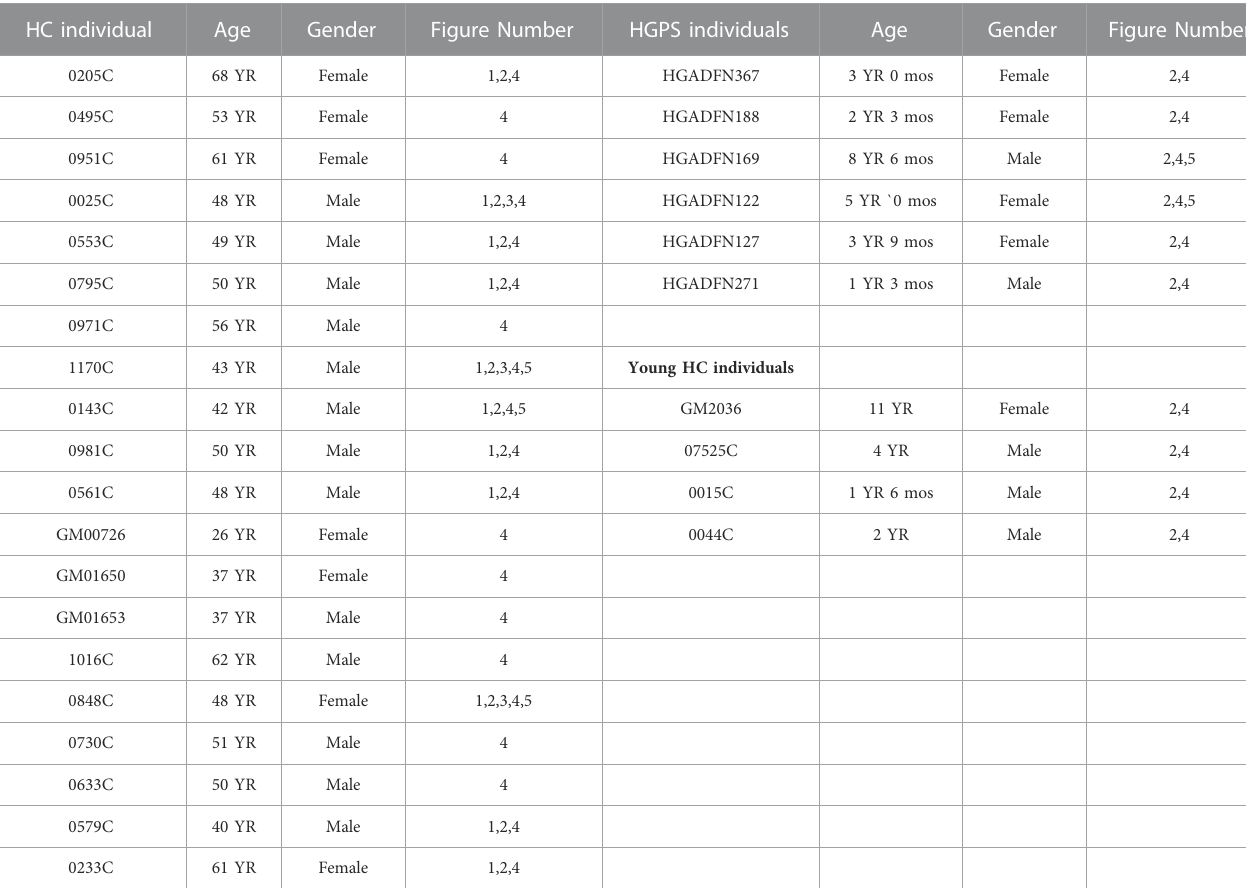
TABLE 2 List of skin fi broblasts control samples (Adult HC, Young HC, and HGPS). HC